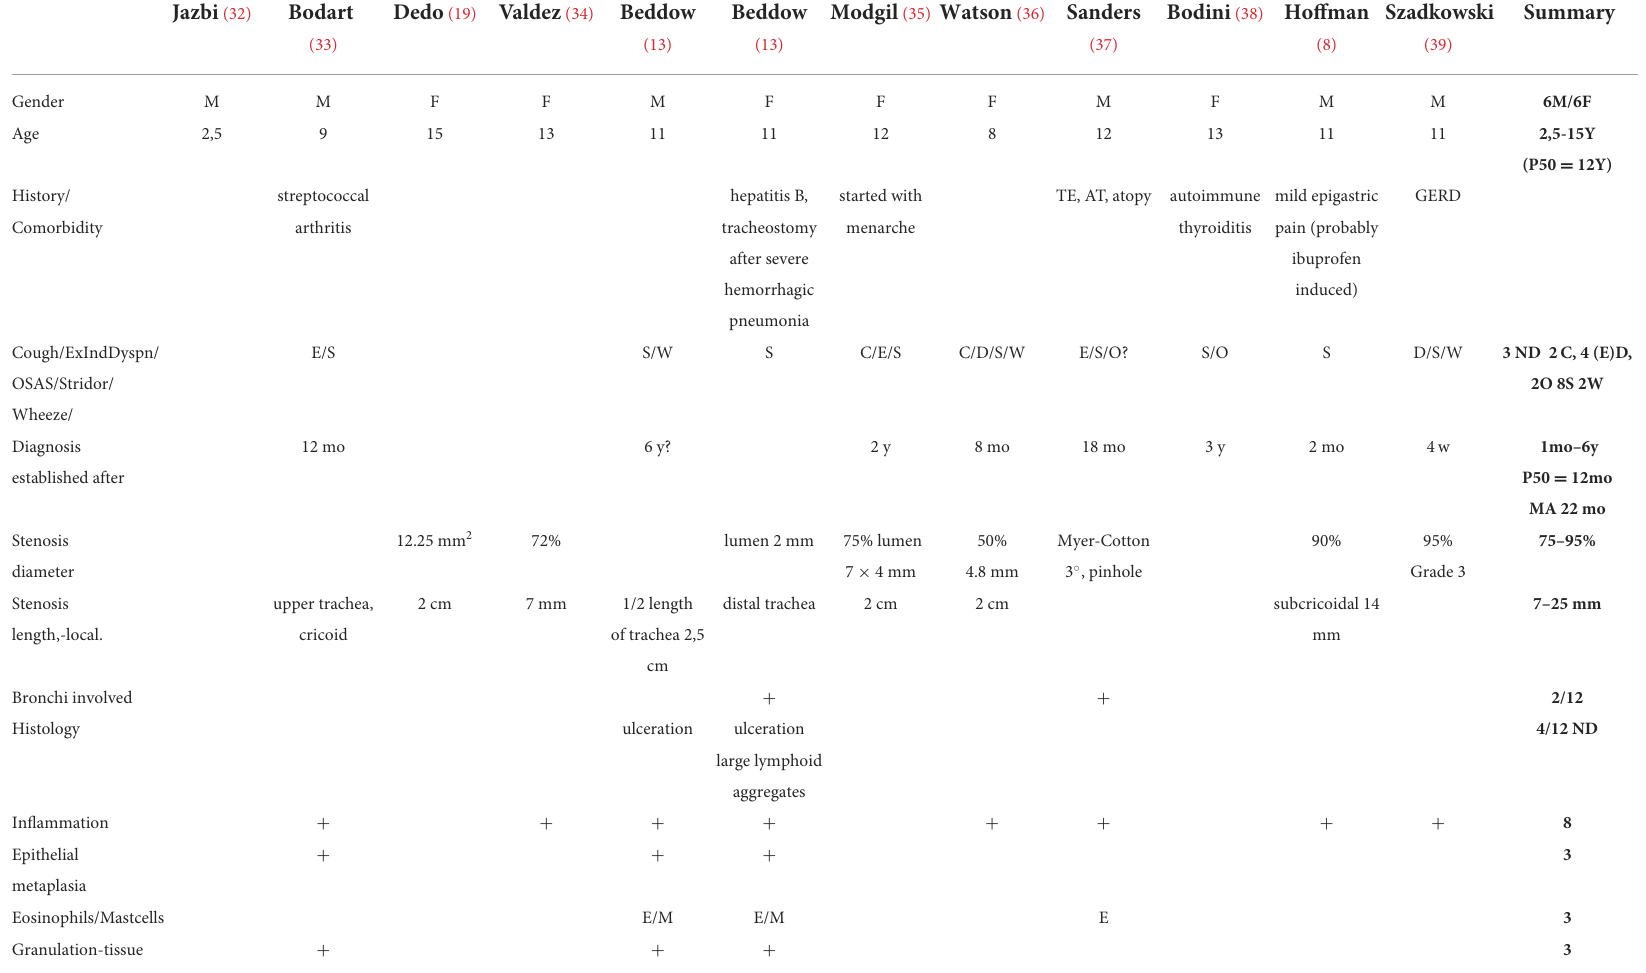
TABLE 2 Clinical characteristics and treatment in pediatric ISGS cases in the